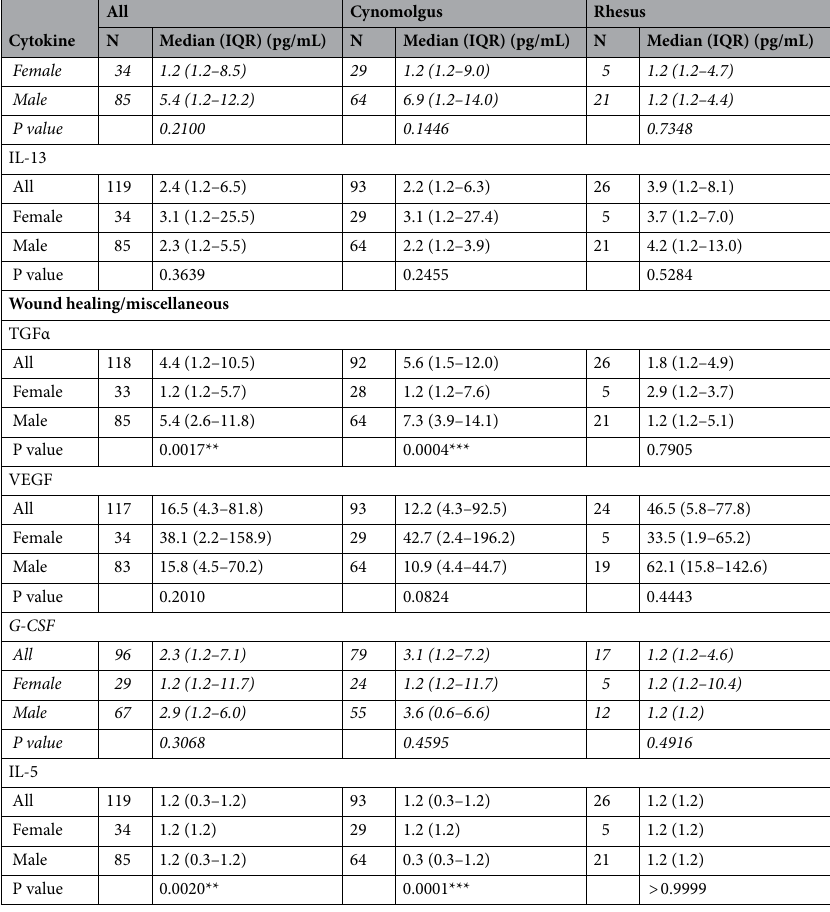
Sedation results in an overall blunting of serum cytokine expression in cynomolgus macaques. To assess the effect of sedation on cytokine detection, detectable ranges were also determined for sampling-method subgroups (cooperating vs. sedated) cynomolgus macaques (Fig. 3, Supplemental Table 9); rhesus macaques were not evaluated due to small sample numbers. Nearly all measured cytokines showed a sig- nificant reduction in detectable concentration in sedated animals as compared to awake, with the exception of IL-8 (similar levels), MIP-1α (slightly increased after sedation), IL-13 (similar levels), VEGF (slightly increased after sedation), G-CSF (similar levels). This suggests an overall blunting effect of sedation on cytokine expression in cynomolgus macaques. Of note, we spiked ketamine directly into three samples to assess if this suppressed cytokine profile was due to a direct interaction of ketamine within the assay. This showed no significant differ- ence in neat (unspiked) compared to spiked samples (Supplemental Table 10), indicating that sedation does blunt the physiologic systemic cytokine response. To further investigate the interaction between sex and sedation on cytokine expression, we compared the cytokine expression of each cohort subset—cooperating females, sedated females, cooperating males, and sedated males (Table 3). We found that the blunted cytokine response seen with sedation persisted in both males and females, but this effect was more dramatic in female subjects, perhaps due to their more dynamic ranges of detec- tion. Differences in cytokine expression between sexes was most apparent when comparing cooperating animals, as sedated animals of both sexes demonstrated a suppressed cytokine response. Overall, subject handling had a significant effect on a higher number of cytokines than sex. These two variables had a significant interaction for the expression of IL-5, IL-8, IL-10, and G-CSF.